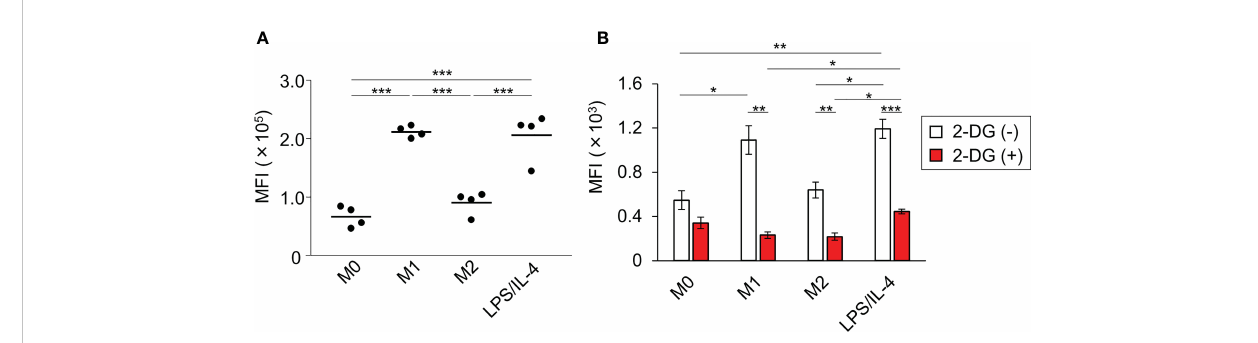
FIGURE 5 LPS/IL-4-induced macrophages show strong, glycolysis-dependent phagocytic activity. Bone marrow-derived macrophages were prepared and stimulated with either LPS, IL-4, or LPS plus IL-4. (A) Phagocytotic assay with fl uorescently labeled microbeads (1 µm) was performed. Mean fl uorescence intensity is shown on the basis of fl ow cytometric analysis. Data are combined from two independent experiments. Horizontal bars indicate mean value. *** P <0.001. (B) Phagocytotic assay with FITC-staining E. coli was performed in the absence or presence of 2-deoxy-D-glucose (2-DG). Results are shown on the basis of fl ow cytometric analysis. Data are combined from two independent experiments. Horizontal bars